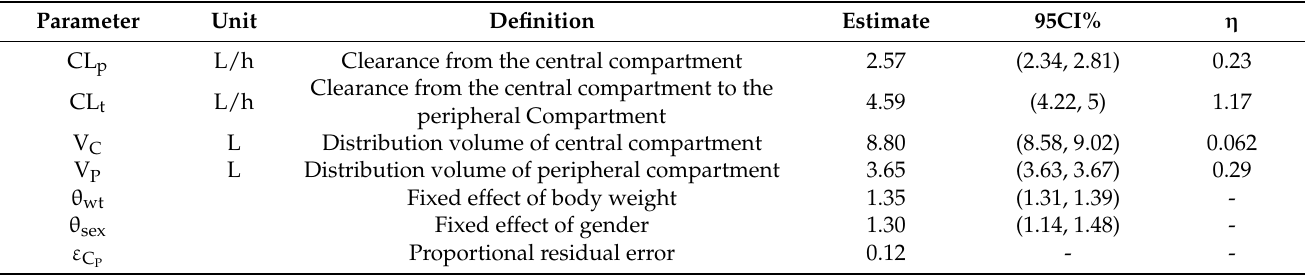
Table 1. Summary of PK model parameters obtained by nonlinear mixed effect to all doses simultaneously. Parameter Unit